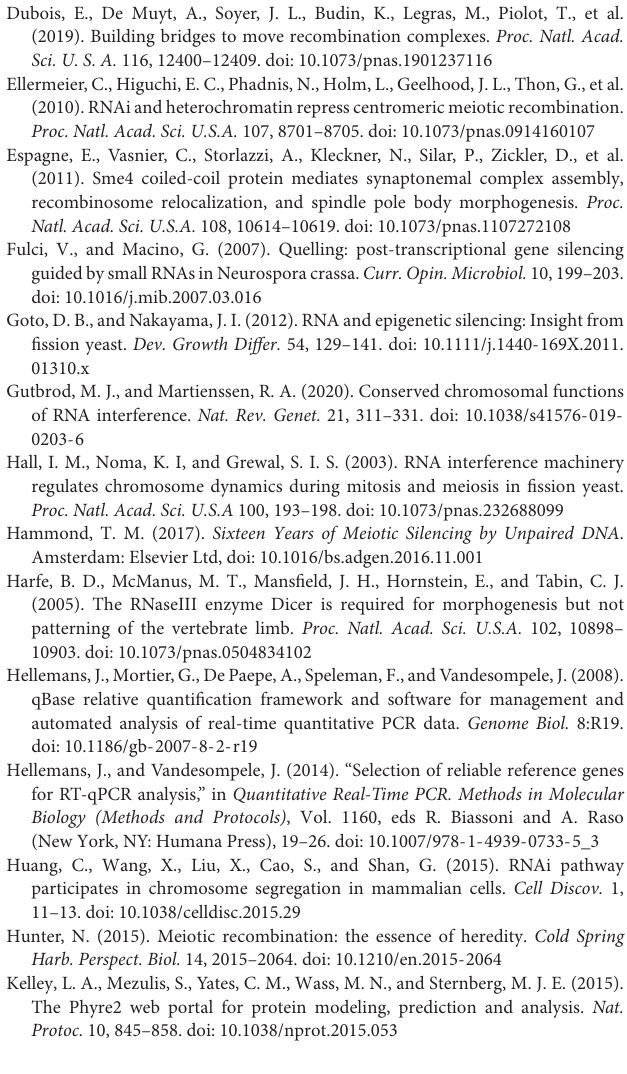
nucleus and the SC length in micron per nucleus in wild type, dcl1 , dcl2, and qde2 . For each nucleus the number of Hei10 foci is plotted against the total length of the SC. Both coefficient of determination (R 2 ) and the regression line are indicated in the graph. (B) Mer3-GFP foci in wild-type (left) and dcl1 (right) leptotene nuclei. (C) Zygotene nuclei of qde2 (left) and dcl2 (middle) with largely open non-synapsed regions (arrows). Note that half of the green homolog in the qde2 nucleus remains completely unsynapsed (green arrow). In contrast, at the same stage, as the dcl2 nucleus, the unsynapsed homologous segments of the WT zygotene are much closer (red arrows in both nuclei). (D) Example of asynchronous SC formation in dcl2 . All homologs are either completely synapsed or with only a short unsynapsed segment (yellow homolog) when the red homolog exhibits a large open segment without any sign of entanglement. Bars, 2 µ m. Supplementary Figure 5 | Chromosome segregation defects in sms2 and dcl1 mutants. (A–C) sms2 mutants. (A) Seven bivalents at diplotene. (B) Three lagging chromosomes are visible in this anaphase I spindle (red arrows). (C) Lagging chromosomes are also visible during anaphase of the second meiotic division (arrow). (D,E) dcl1 mutant. (D) Irregular chromosome segregation during anaphase of the second meiotic division. In the left spindle, 4 or 5 chromosomes are at one pole and 9 at the other pole, when a 7/7 segregation is expected. Segregation is also defective in the right spindle (arrow). (E) Irregular segregation leads to pear-shaped telophase nuclei (arrow). Bars, 2 µ